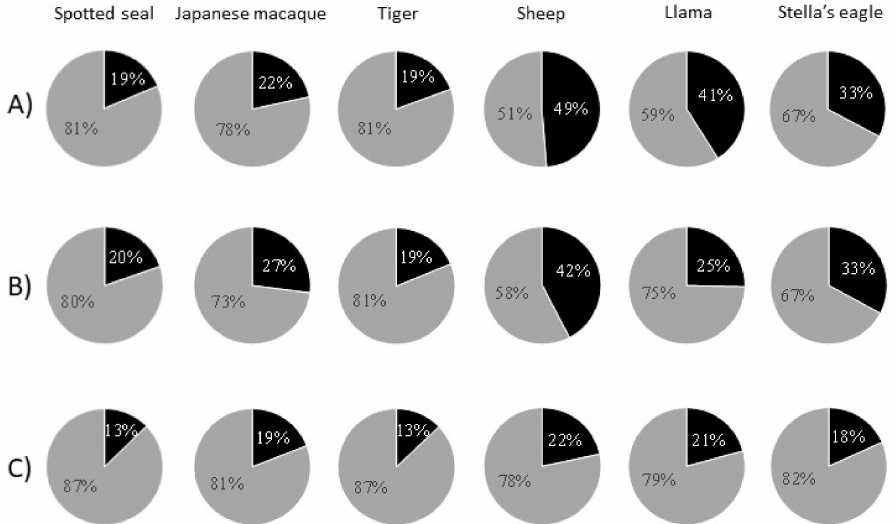
Figure 3. Percentage of visitors on different behavior in target species. ( A ) Control, ( B ) Stamp collecting, ( C ) Quiz game. Grey and black of pie chart show animal observation with stopping and without stopping,